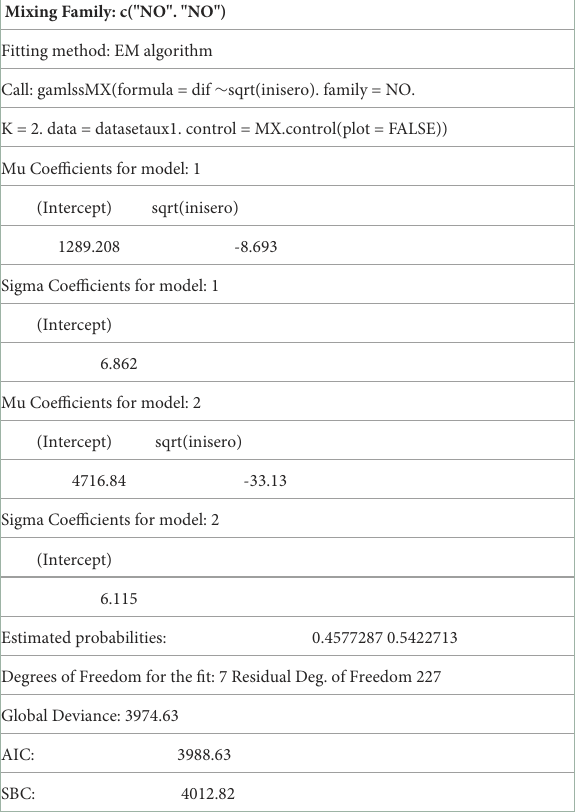
TABLE 5 Generalized additive model of normal mixture distribution where the dependent variable is the increase in antibodies. Mixing Family: c("NO".